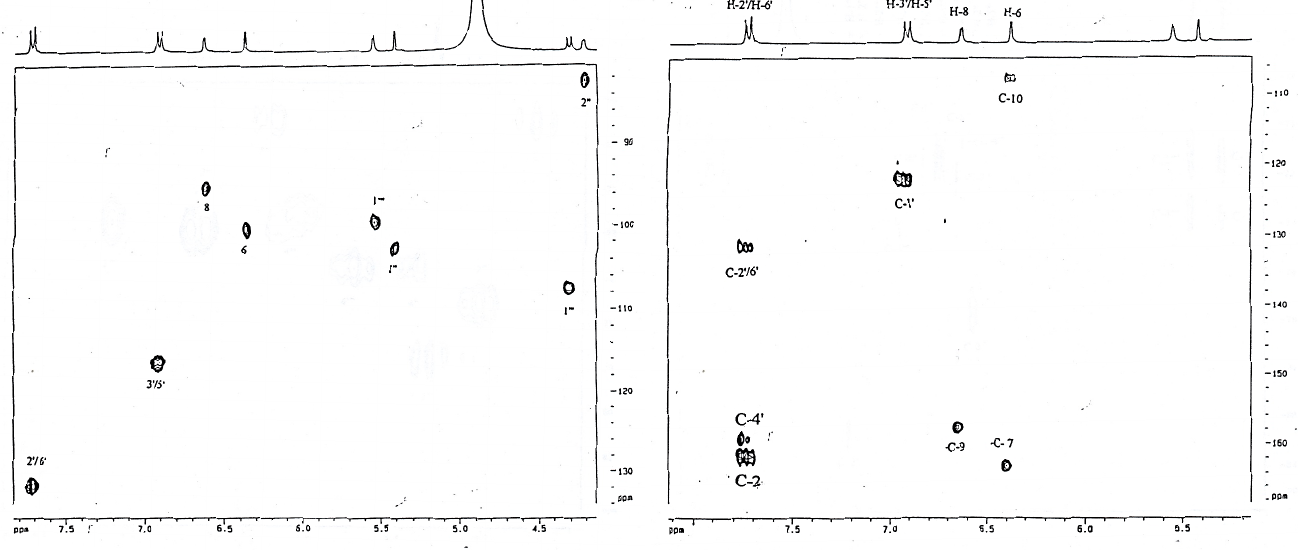
Figure S7: HMBC spectrum of sagittatin A (300 MHz; CD 3 OD). Magnification of 5.0 - 8.0/100 -170 ppm region.